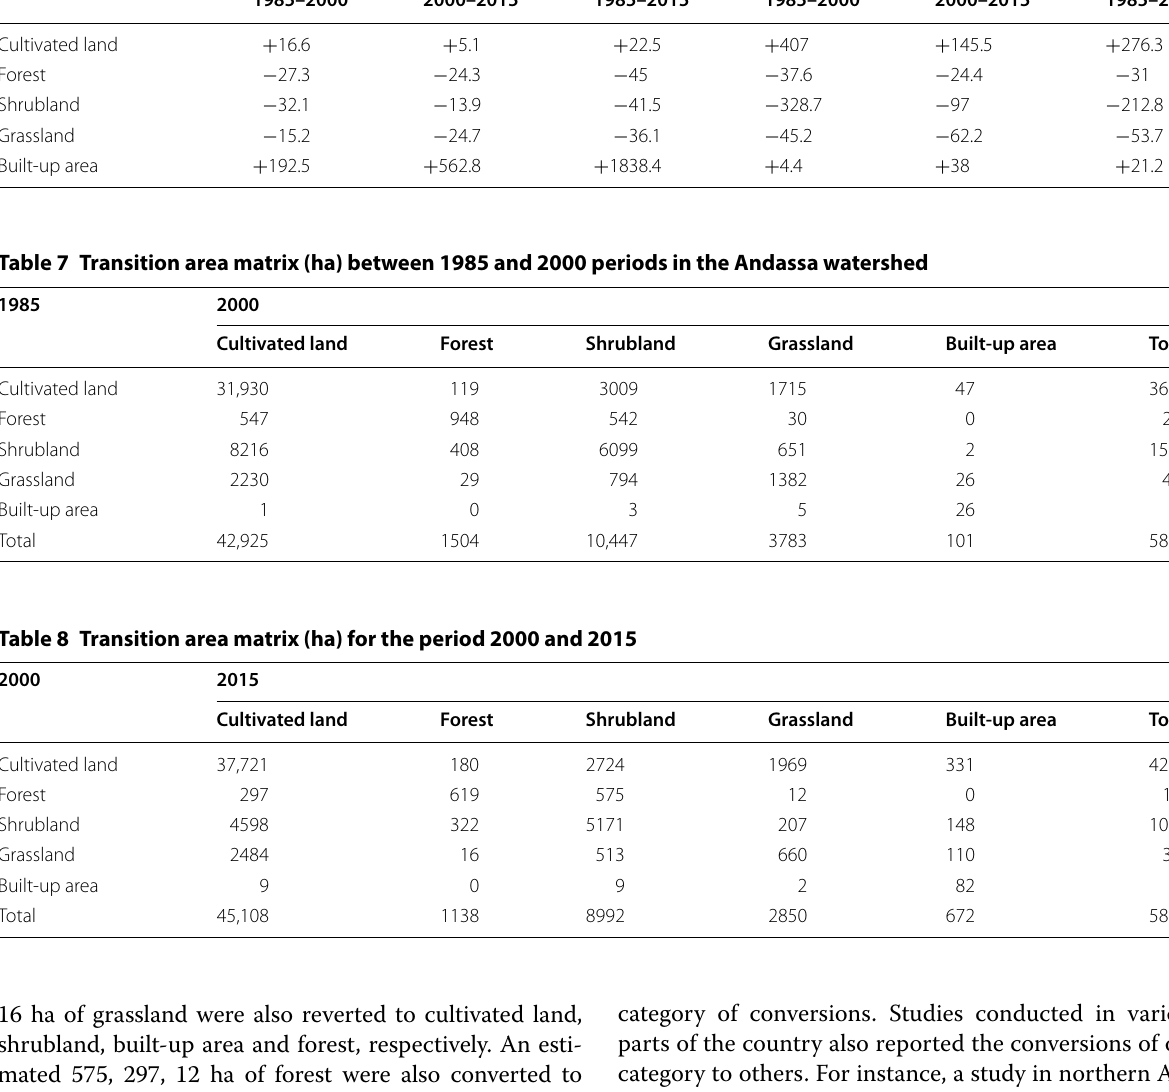
Cultivated land